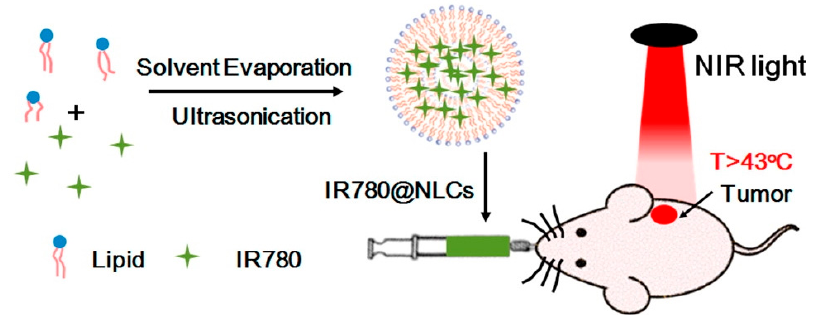
Figure 13. Preparation of IR780@NLC and the mechanism of anticancer therapy. Reproduced with permission from the publisher of corresponding reference [260].